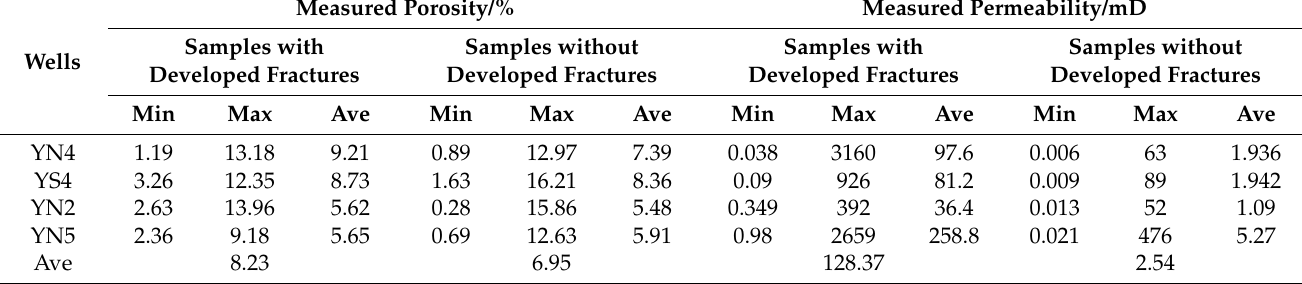
Table 1. Porosity and permeability of the J 1 a sandstone in Dibei area (part of the data is from Hailiang Kang [24]).